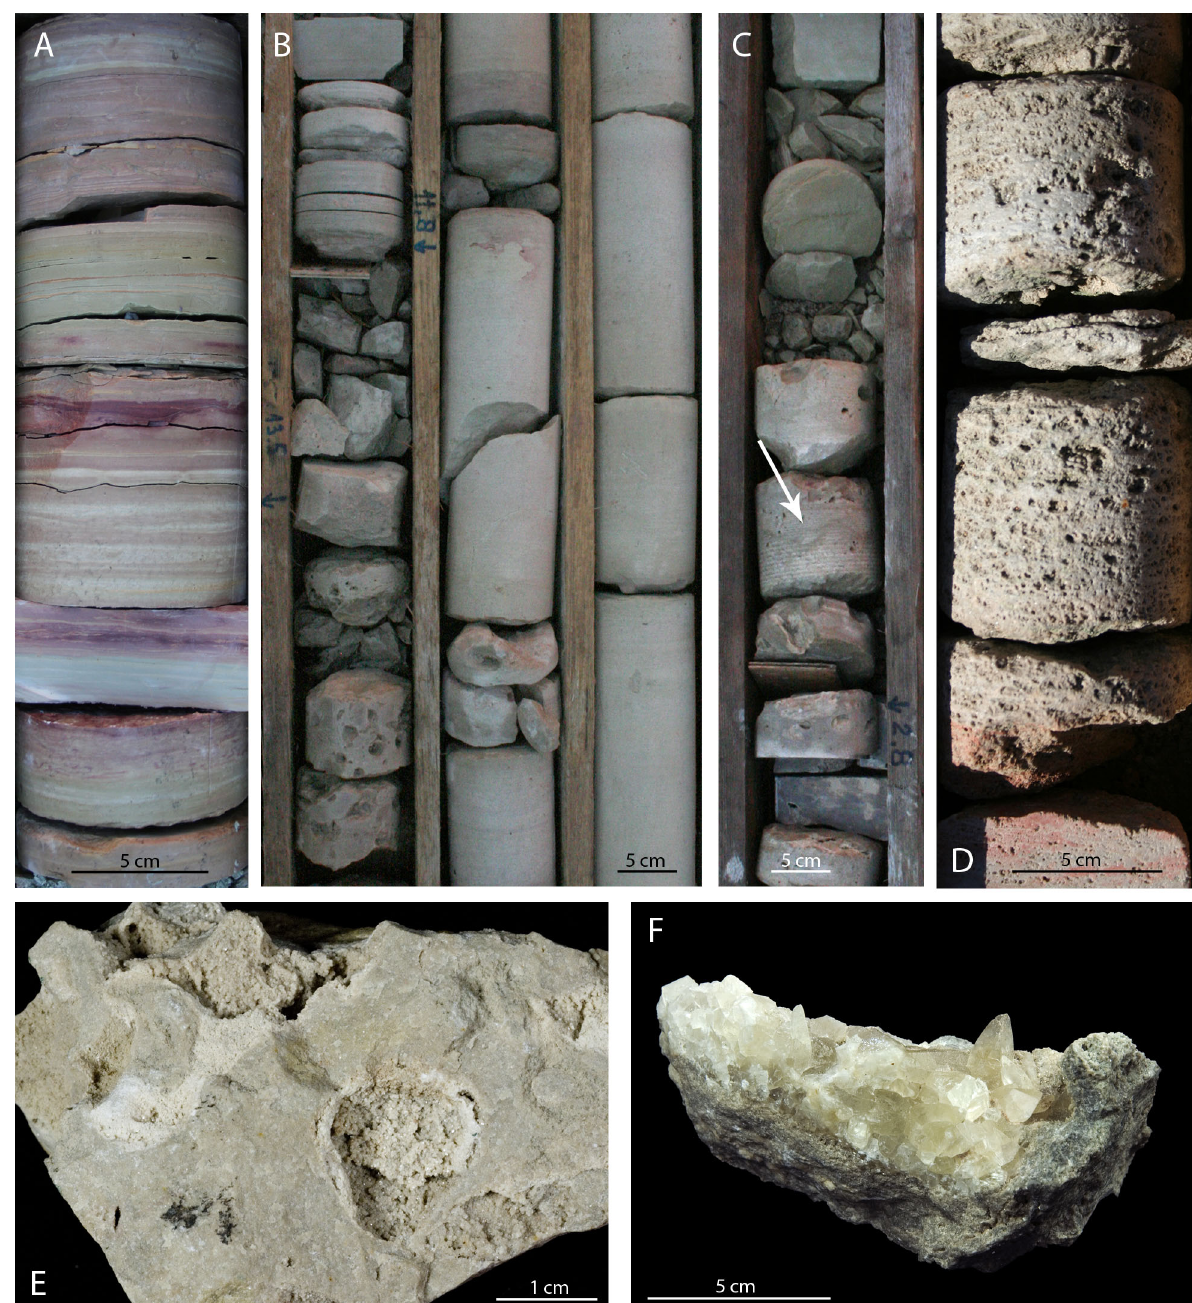
Fig. 3. Photographs illustrating the lithology of the studied rocks. ( A ) Platy dolostone of the Snetnaya Gora Fm, Ape drill core, 16.3(cid:150)16.7 m. ( B ) Variegated porous and thin-bedded (left) and thick-bedded compact (right) dolostone, typical of the Lower Pskov unit, Ape drill core, 9.4(cid:150)12.5 m. ( C ) Lenticular-vavy bedded very finely crystalline vuggy dolostone with stylolite planes (arrow) occurring in the Upper Pskov unit, Ape drill core, 2.0(cid:150)2.8 m. ( D ) Sucrosic dolostone, characteristic of the Upper Pskov unit, Ape drill core, 1.2(cid:150)1.5 m. ( E ) Moldic pores in the Upper Pskov unit; Tsiistre drill core, 46.0 m, GIT 156-305. ( F ) Calcite filling in the Upper Pskov unit, Marinova quarry, GIT